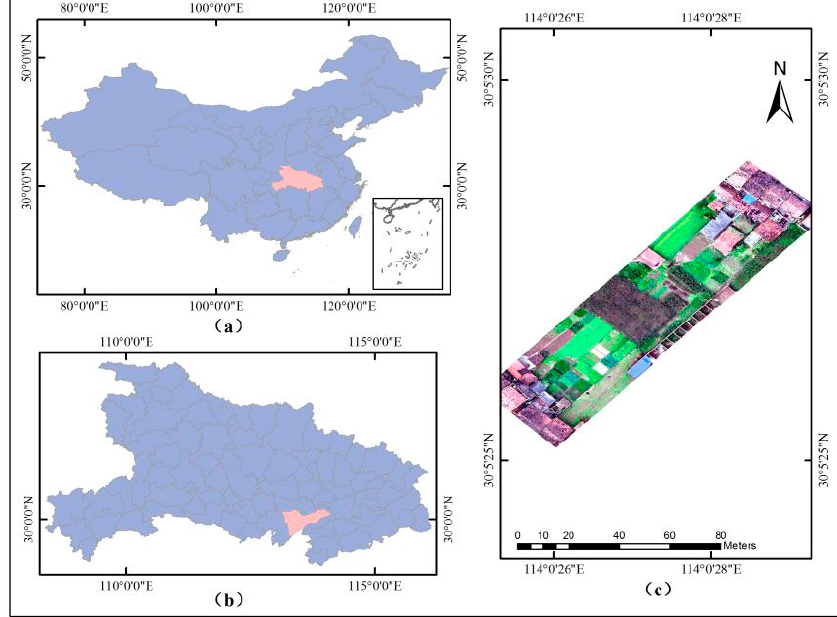
Figure 5. ( a ) The location of Hubei province in China. ( b ) Administrative area map of the city of Honghu in Hubei province. ( c ) The study site.